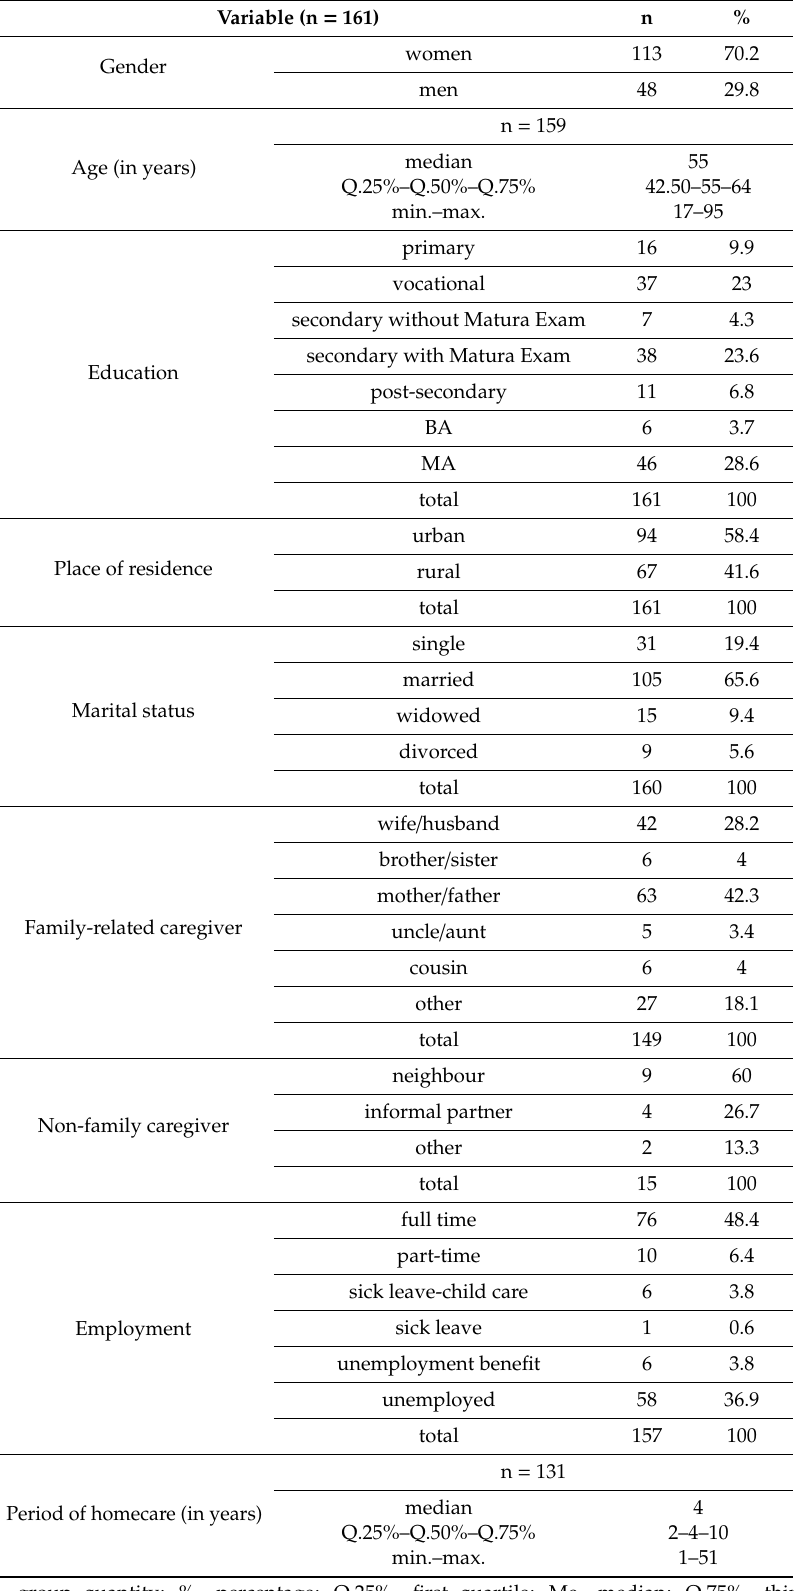
Table 2. Sociodemographic data of caregivers